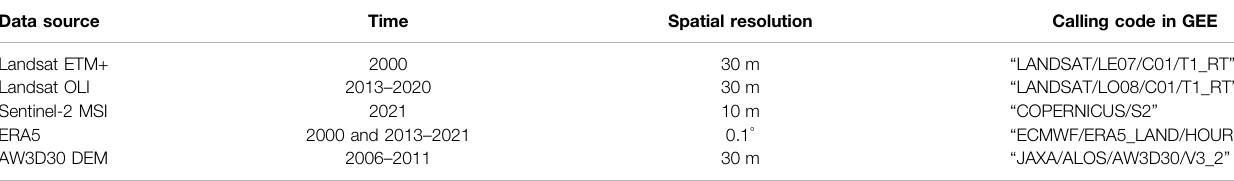
TABLE 1 | Data used in this